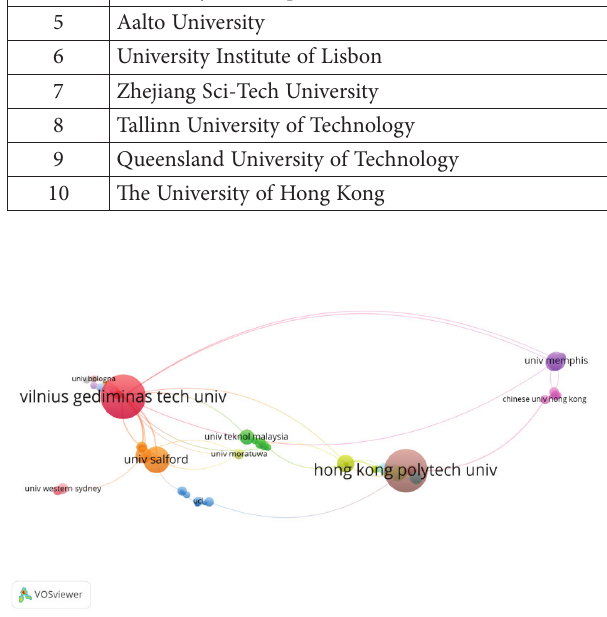
Figure 6. Organization co-authorship network of the IJSPM